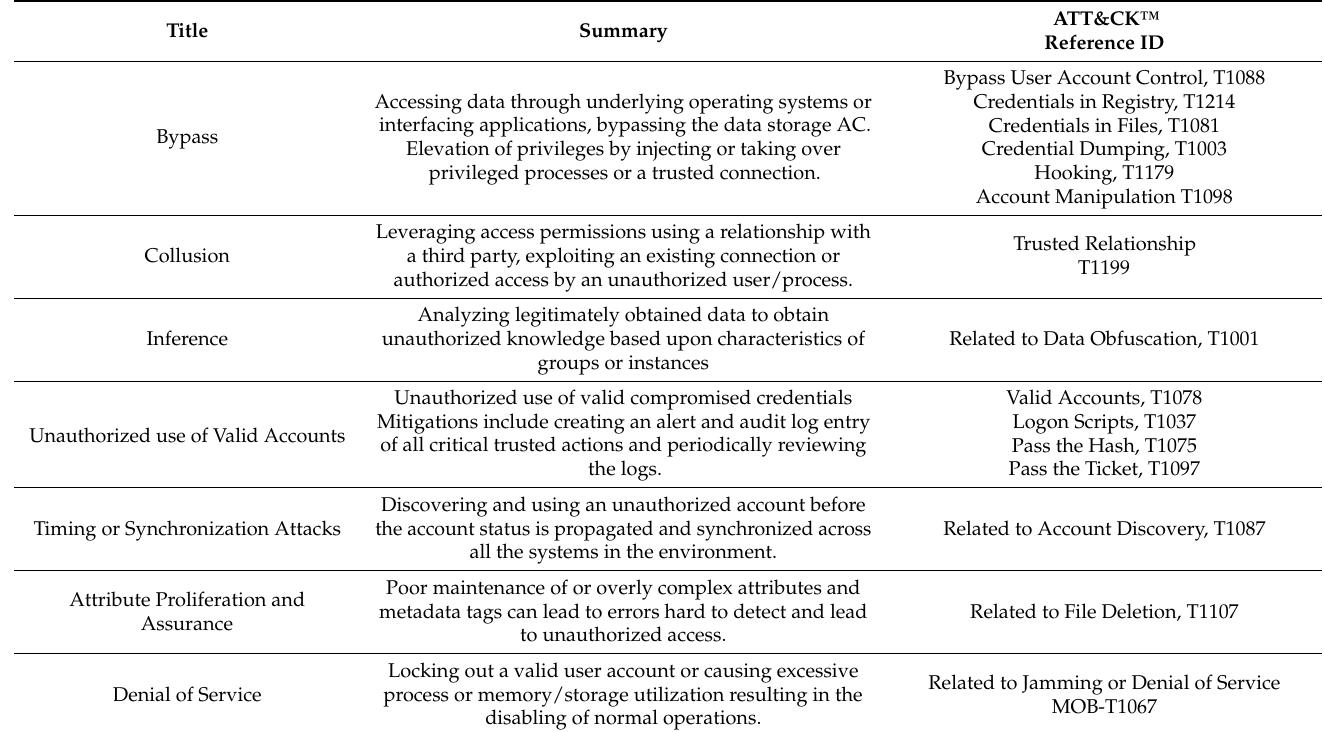
Table 2. Summary of Threats to AC